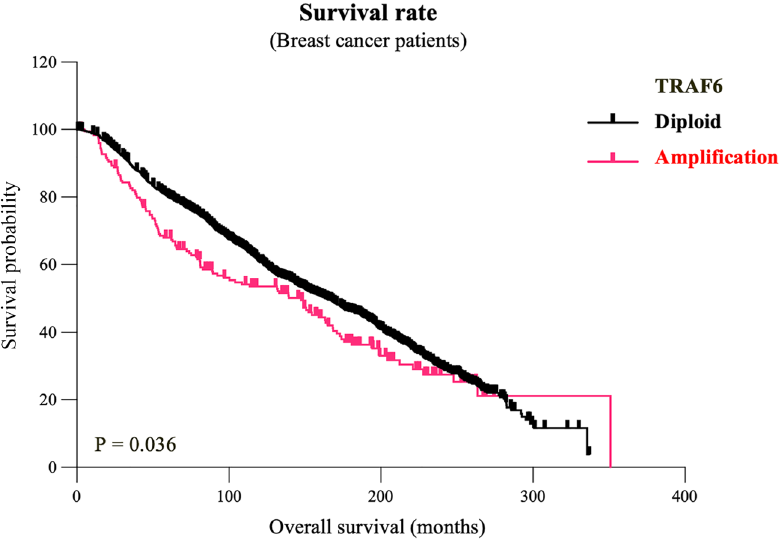
Figure 4. Genetic alterations in TRAF6 are associated with breast cancer survival. Analysis of copy number variations (CNVs) and cumulative survival rate in breast cancer patients (The METABRIC dataset). Patients are separated into those who were diploid for TRAF6 (n = 1738) and others who exhibited gain or amplification of TRAF6 (n = 213) (P =